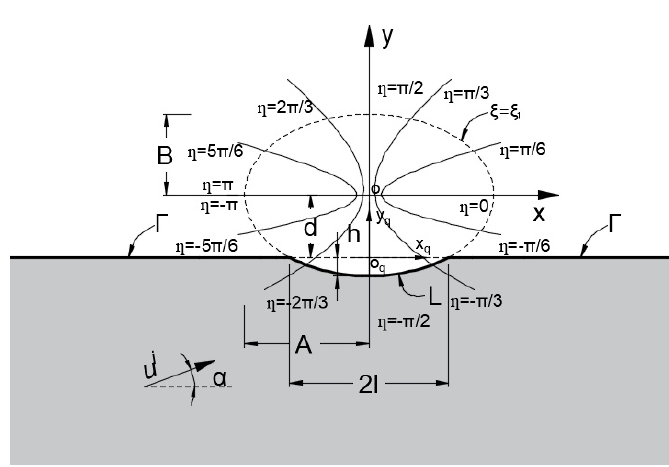
Figure 1. The two-dimensional half-space model containing an elliptical-arc canyon.